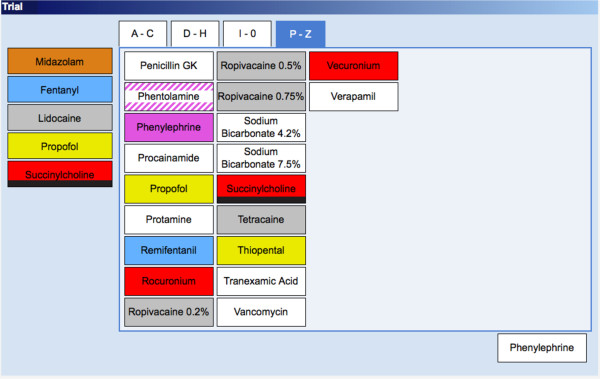
Screen shot of alphabetical display format. This drug entry screen was constructed with "tabs" across the top labeled A-C, D-H, I-O and P-Z. Under each tab, individual drugs were listed in alphabetical order.